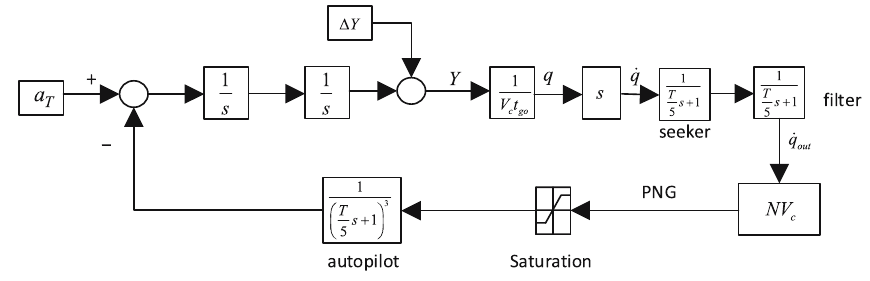
Figure 10: Linearized PNG guidance